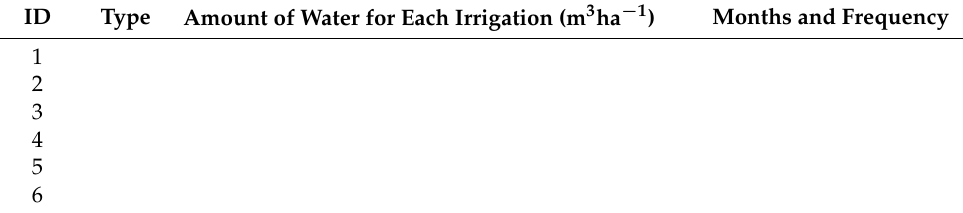
Table A3. Information on irrigation supply. Indicate the type, quantity, and frequency of